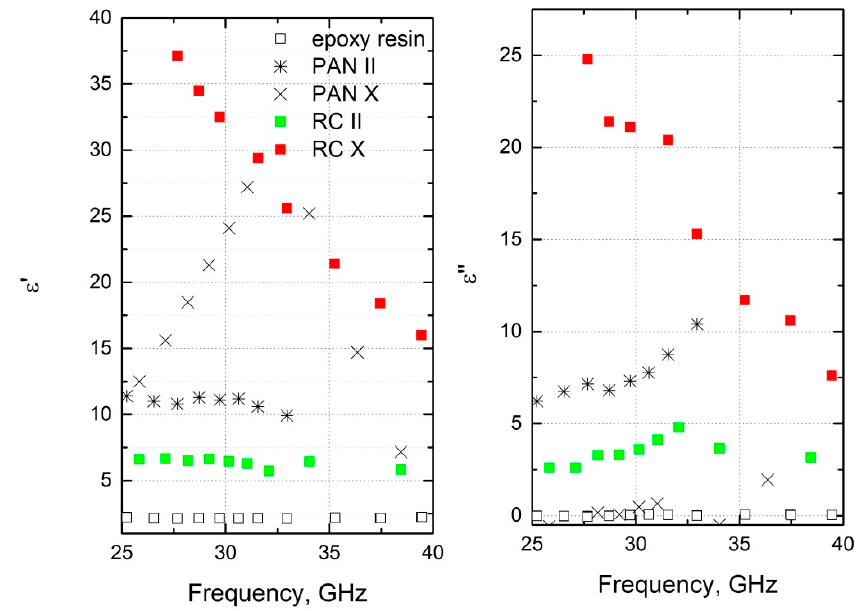
Figure 5. Microwave spectra of carbon fiber felt composites.